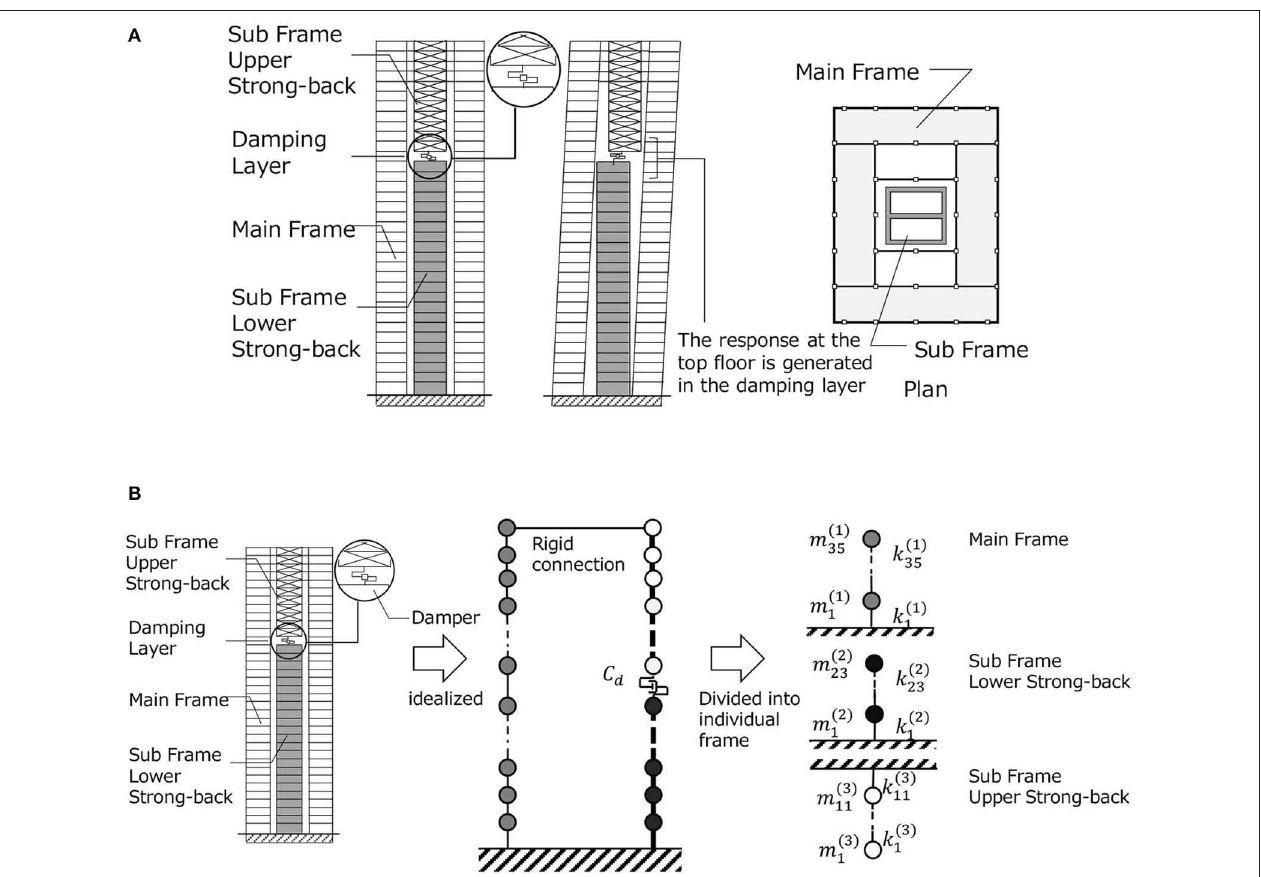
FIGURE 1 | Proposed control system using large-stroke viscous dampers through connection to strong-back core frame. (A) Overview of building with control system and (B) Simplification of controlled building system into MDOF model and decomposition into subassemblage